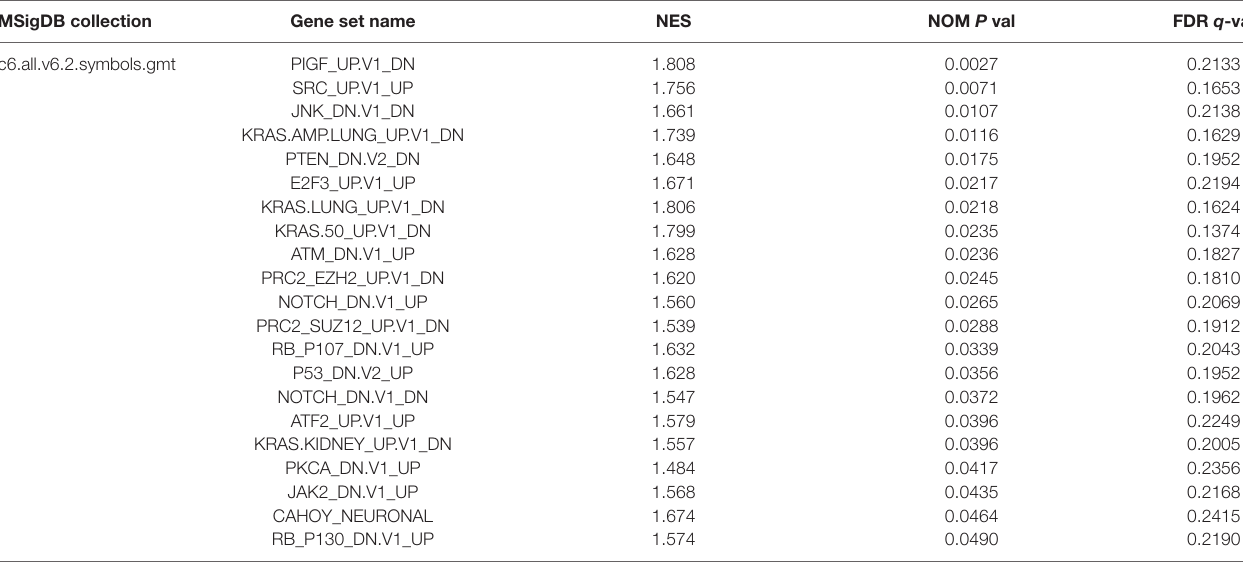
TABLE 7 | Gene Set Enrichment Analysis in EMX1